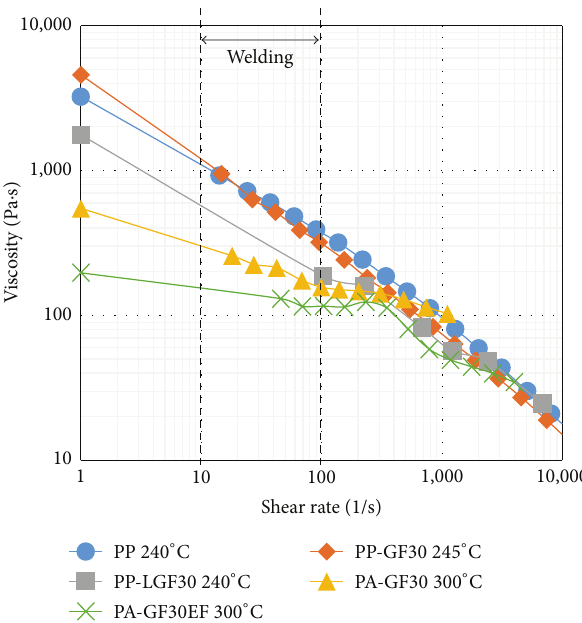
Figure 2: Viscosity